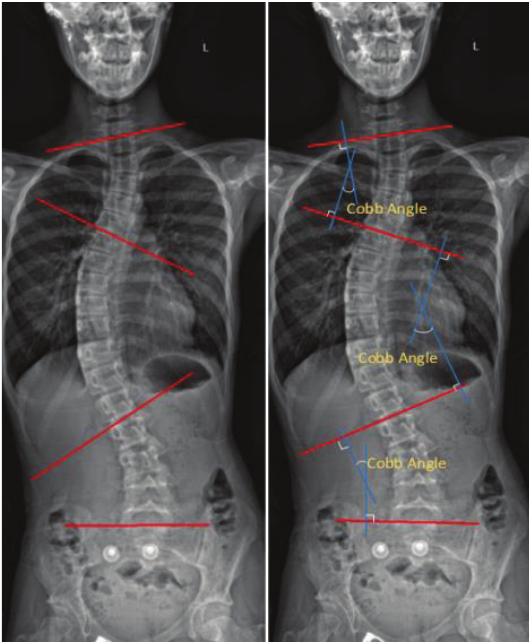
Figure 7. Before and after correction.